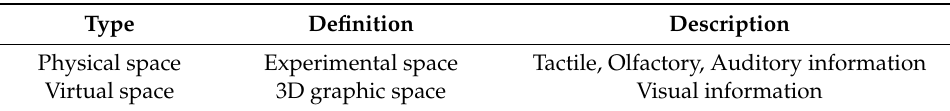
Table 3. Definition of virtual-physical space.